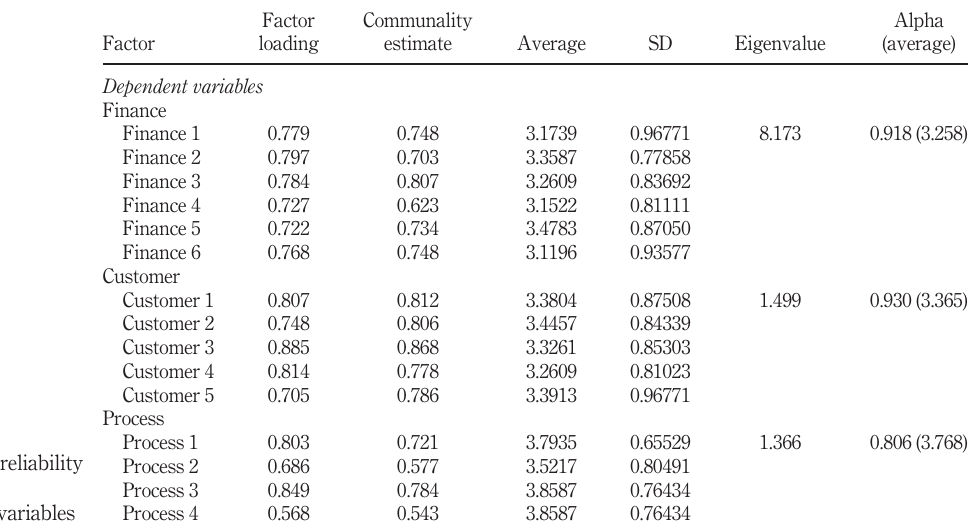
Table II. Factor and reliability analyses